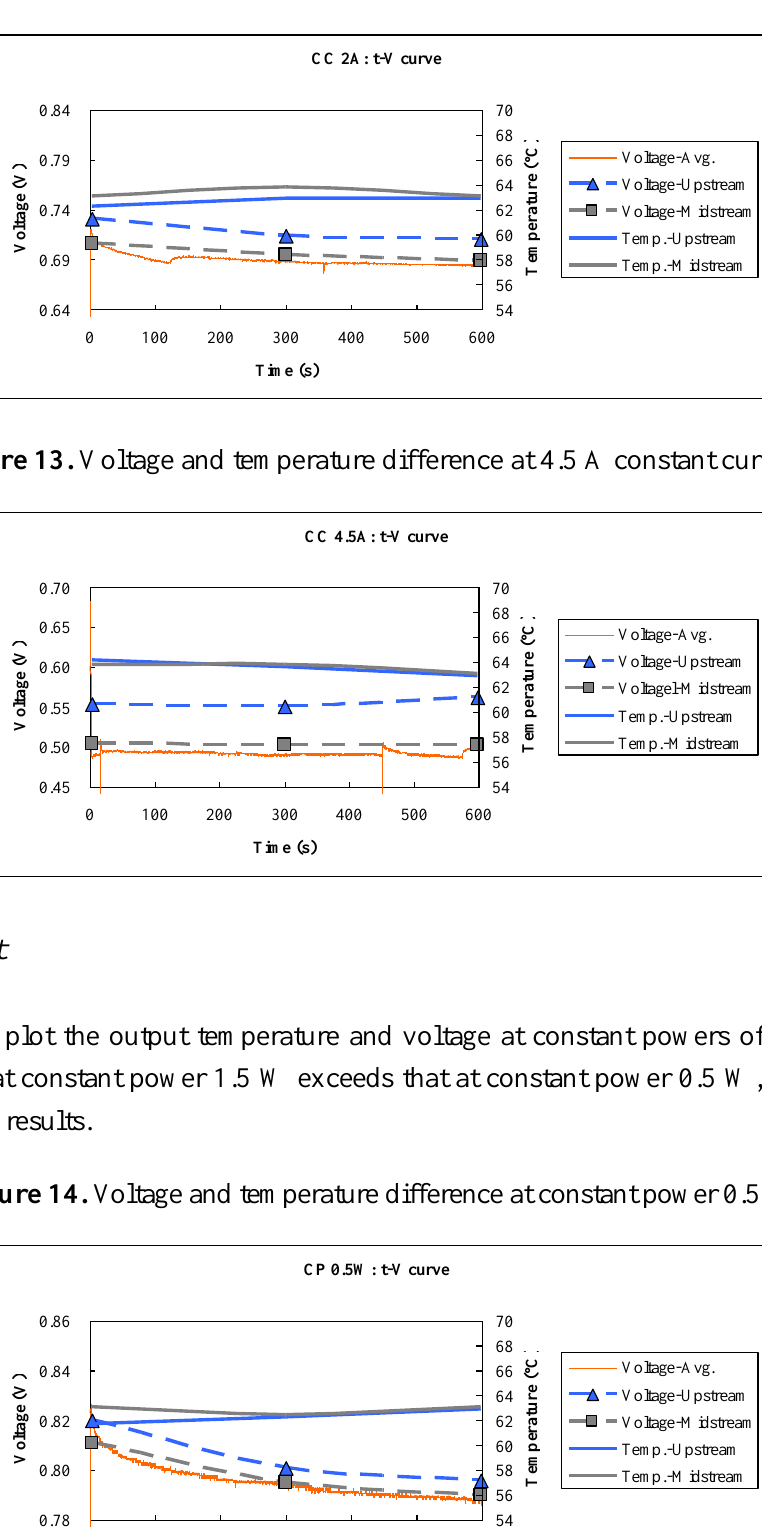
Figure 12. Voltage and temperature difference at 2 A constant current.